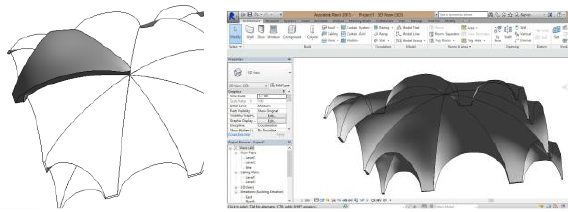
Fig. 4. The vault is a parametric object. The thickness can be set to modify the shape.